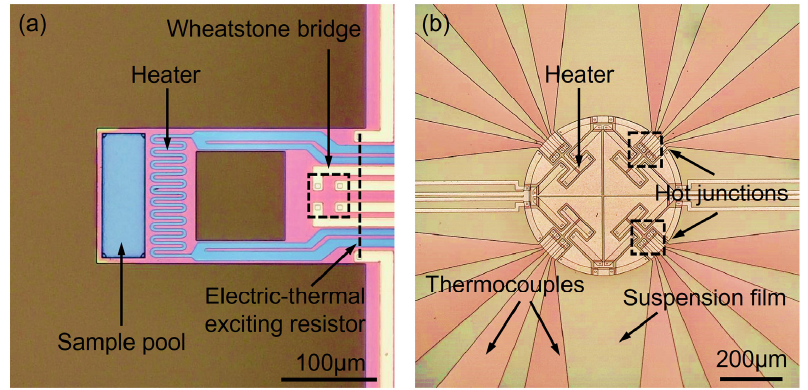
Figure 2. Top-view microphotograph showing the layout of the fabricated TG/DTA chips. ( a ) Can- tilever beam of MR-TGA. ( b ) DTA thermocouple and heating plate in one suspended diaphragm.